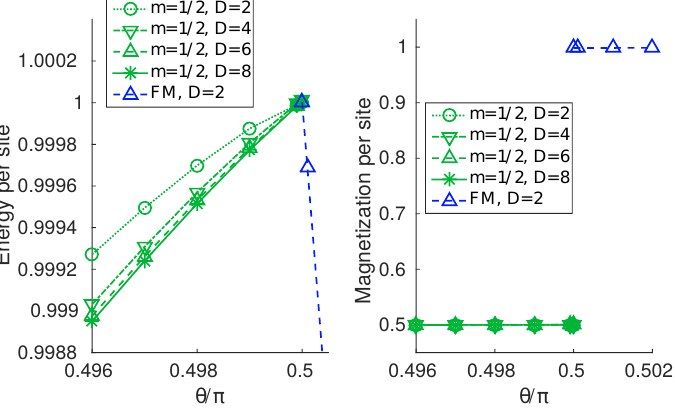
Figure 12: Energy per site (left) and magnetization per site (right) for the partially magnetized ( m = 1 / 2) and ferromagnetic (FM) phases as a function of θ . Because both states are product states at the critical point, no D → ∞ extrapolation is needed. The kink in energy and jump in magnetization show that this is a clear first order